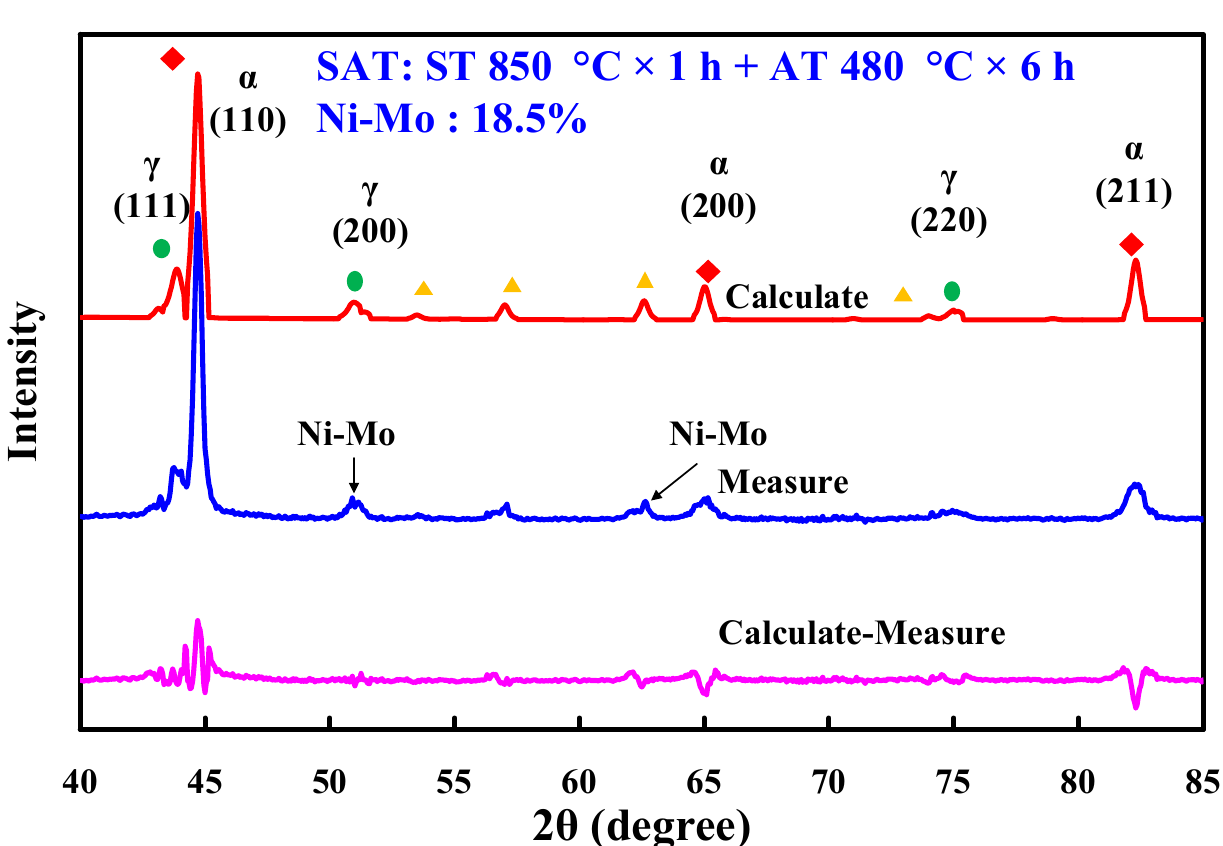
Figure 6. X-ray diffraction patterns of the test specimen processed by SAT with the optimal procedures. Figure 7 shows two pairs of injection molds before and after SAT heat treatment. After the optimum heat treatment procedure, post-process finishing operations used a precision milling machine to obtain the desired dimensions of the injection mold. Figure 8 shows the results of the coolant leakage test for an injection mold with CCC. As ex- pected, there was no coolant leakage for the injection mold with CCC after SAT at 480 °C for 6 h. The proposed method solved the coolant leakage problem with no detrimental effects on the functions of either the injection mold or the CCC. However, the as-built injection mold had coolant leakage of approximately 276 g, 184 g, and 92 g after a test time of 3, 2, and 1 h, respectively. This indicates that the coolant leakage for a direct-metal- printed injection mold with CCC can be reduced by combining injection-mold fabrication with general process parameters and SAT.